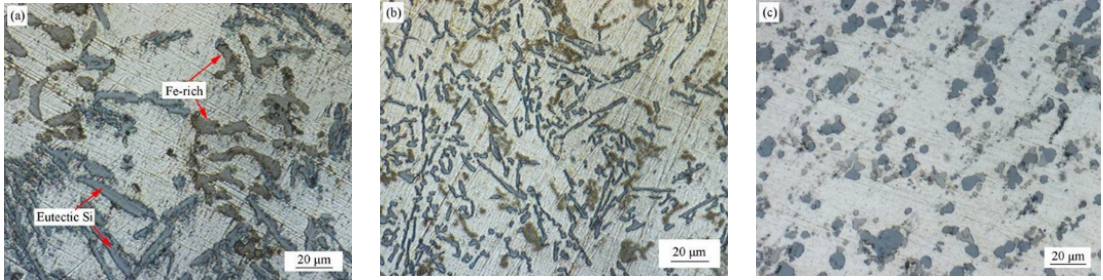
Figure 3. Microstructures of ( a ) Al ‐ 5Si ‐ 1Cu ‐ 0.5Mg alloy as cast, ( b ) SiCp/Al ‐ 5Si ‐ 1Cu ‐ 0.5Mg composites, and ( c ) T6 heat ‐ treated SiCp/Al ‐ 5Si ‐ 1Cu ‐ 0.5Mg composites. Table 2. Some properties of the samples used in the wear tests.